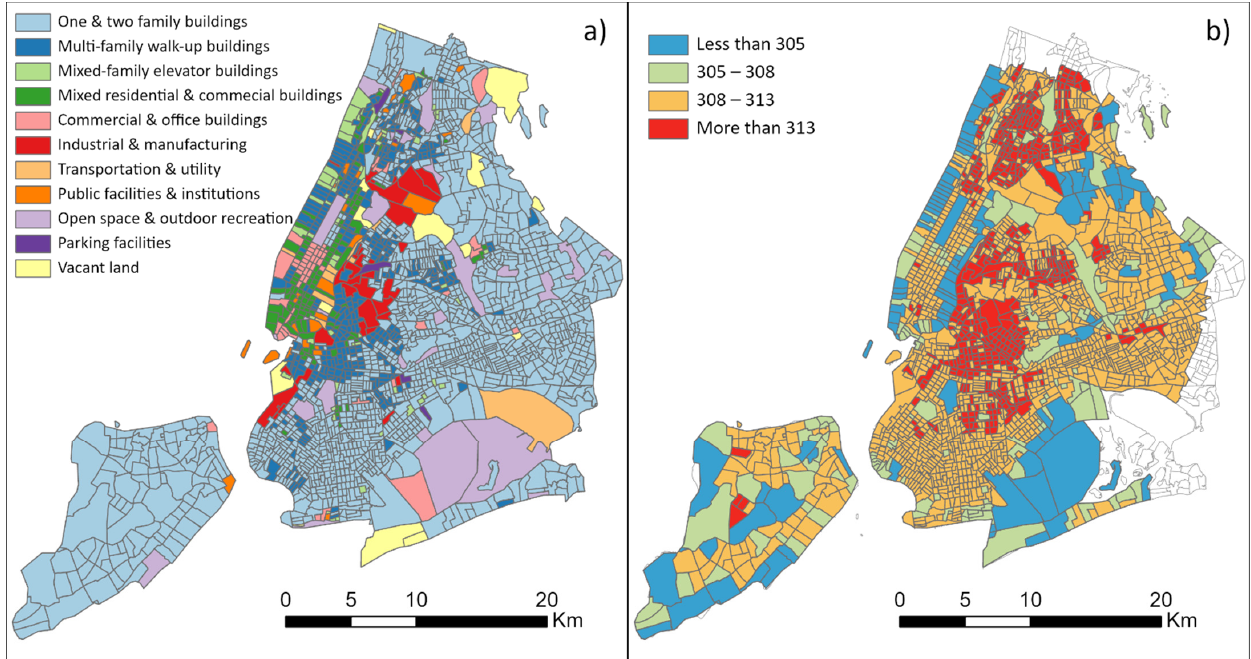
Figure 7. Choropleth maps show: ( a ) Dominant building’s land use and ( b ) surface temperature (mean, K) in different census tracts of New York City.